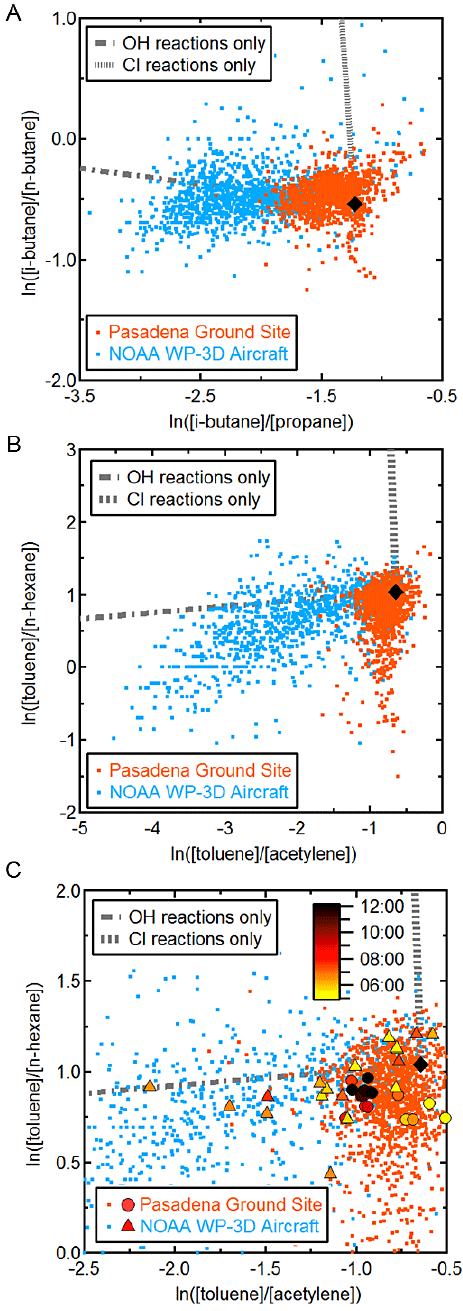
Fig. 2. VOC tracer ratios measured at the Pasadena CalNex ground site and on the WP-3D aircraft. (A, B) All data for all days for the entire campaign. The lines indicate expected tracer ratio evolution for OH and Cl oxidation starting from Los Angeles Basin emission ratios (black diamonds) determined by Borbon et al. (2013). (C) Data from (B) on expanded axes with data collected from 05:00 to 13:00PDT on 3 June 2010 at the ground site and from the aircraft at altitudes below 1000m identified by large symbols, color-coded by time of